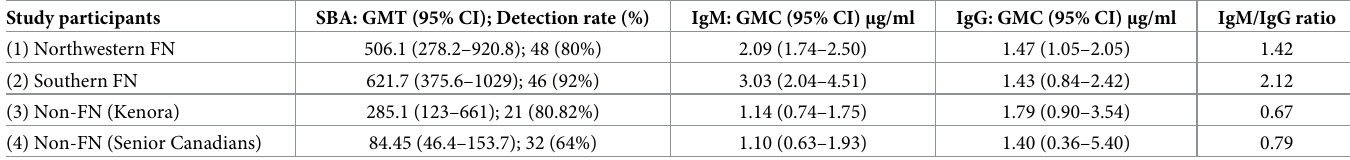
Table 4. Concentrations of IgM and IgG antibody specific for Hia polysaccharide and titres of bactericidal antibody against Hia 08–191 (with exogenous comple- ment) in adult First Nations and non-First Nations individuals. Study